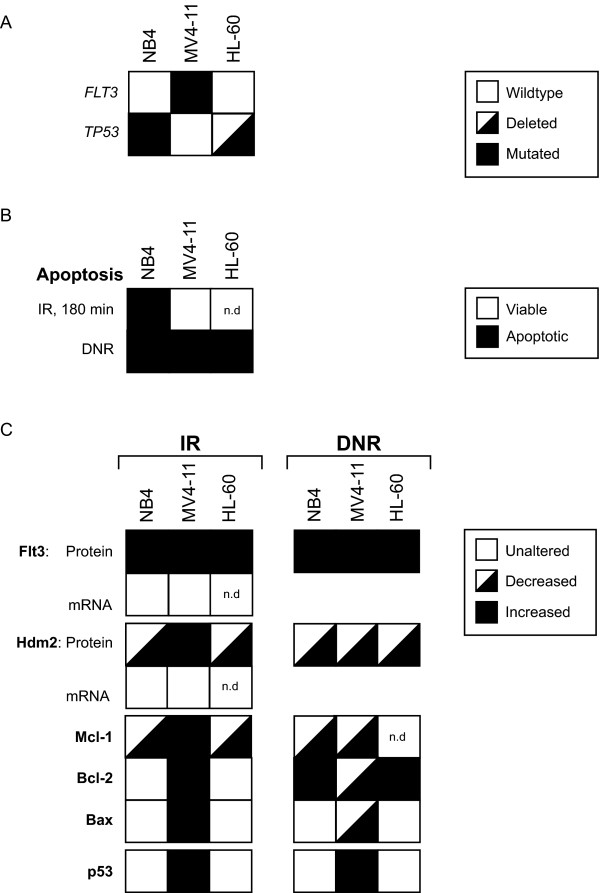
Summary of the results. A. FLT3 and TP53 mutational status of the cell lines used in this study. B. A summary of the ability of IR and DNR to induce apoptosis in the three different cell lines studied (n.d; not determined). C. Overview of the concerted protein modulations elicited by DNA-damaging therapy found in this study (n.d; not determined).